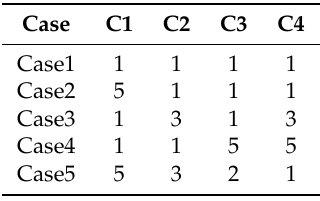
Table 3. Five cases of proportional blending in the